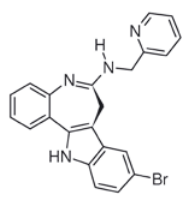
Figure 1. Chemical structure of amidine 1